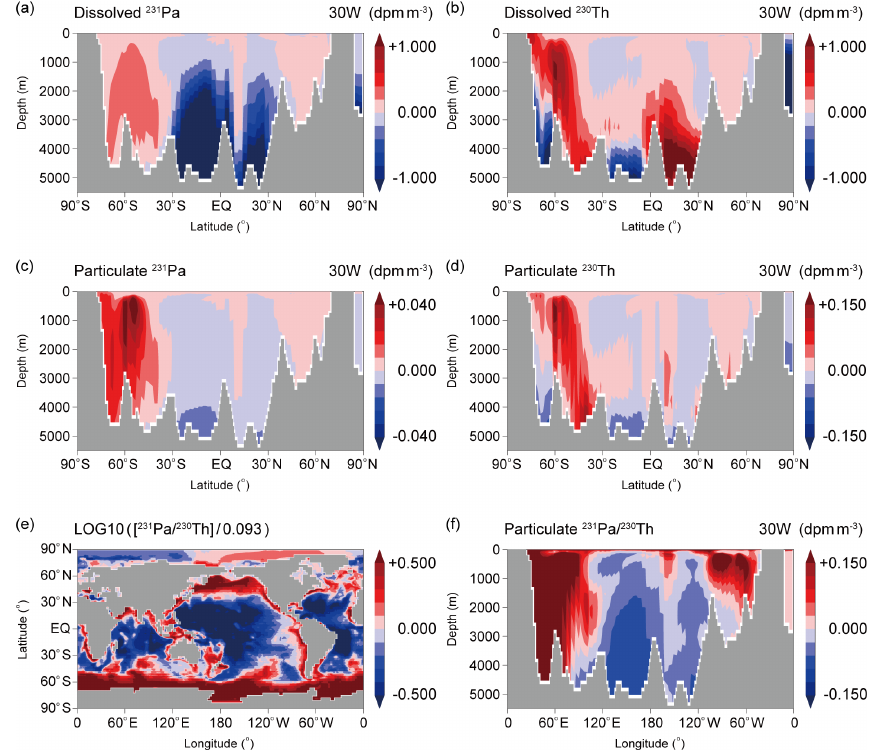
Figure 7. The difference between 3D_EXP and 1D_EXP (i.e., 3D_ EXP minus 1D_EXP, which represents for ocean transport effect) of (a) dissolved 231 Pa, (b) dissolved 230 Th, (c) particulate 231 Pa, and (d) particulate 230 Th along 30 ◦ W in the Atlantic Ocean. (e) The difference between 3D_EXP and 1D_EXP of sedimentary 231 Pa / 230 Th ratios is normalized by the production ratio of